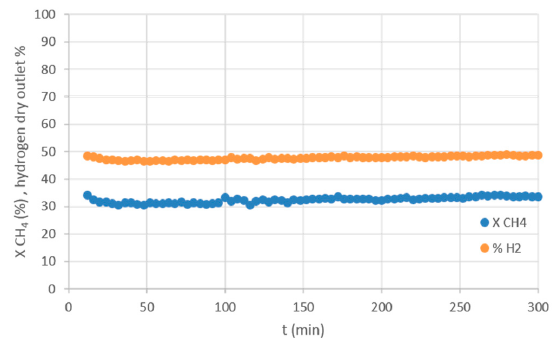
Figure 16. Methane conversion and hydrogen dry outlet percentage obtained on Rh0.05-CL-R-ZOm tested at 750 °C, 30,000 h − 1 , 1 atm and S/C 1.5.